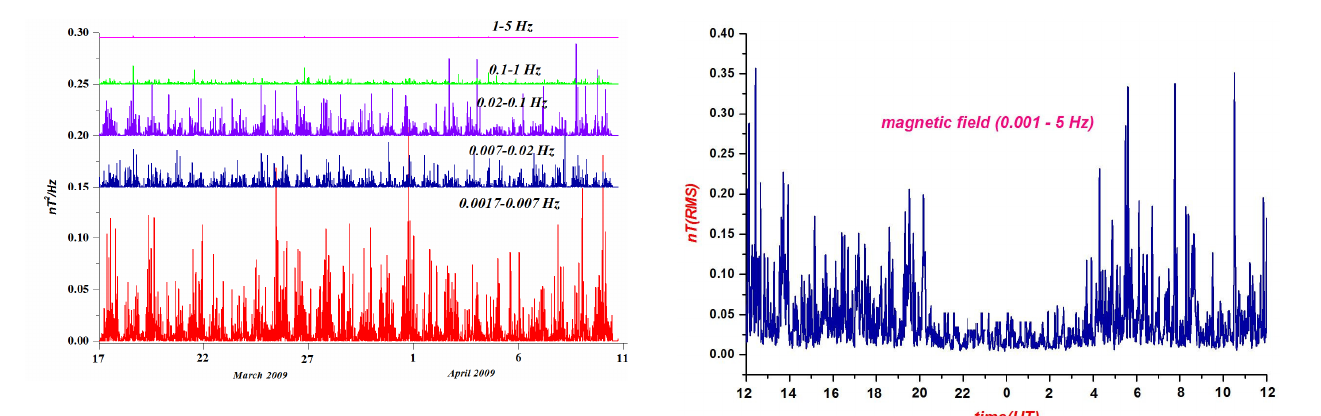
Fig. 1. Continuum magnetic background noise at L’Aqula Geomag- Fig. 1 Diurnal variation of magnetic intensity field observed at L’Aquila Geomagnetic netic Observatory. Observatory for all ULF emissions in the frequency band from 0.0017 Hz to 5 Hz. .